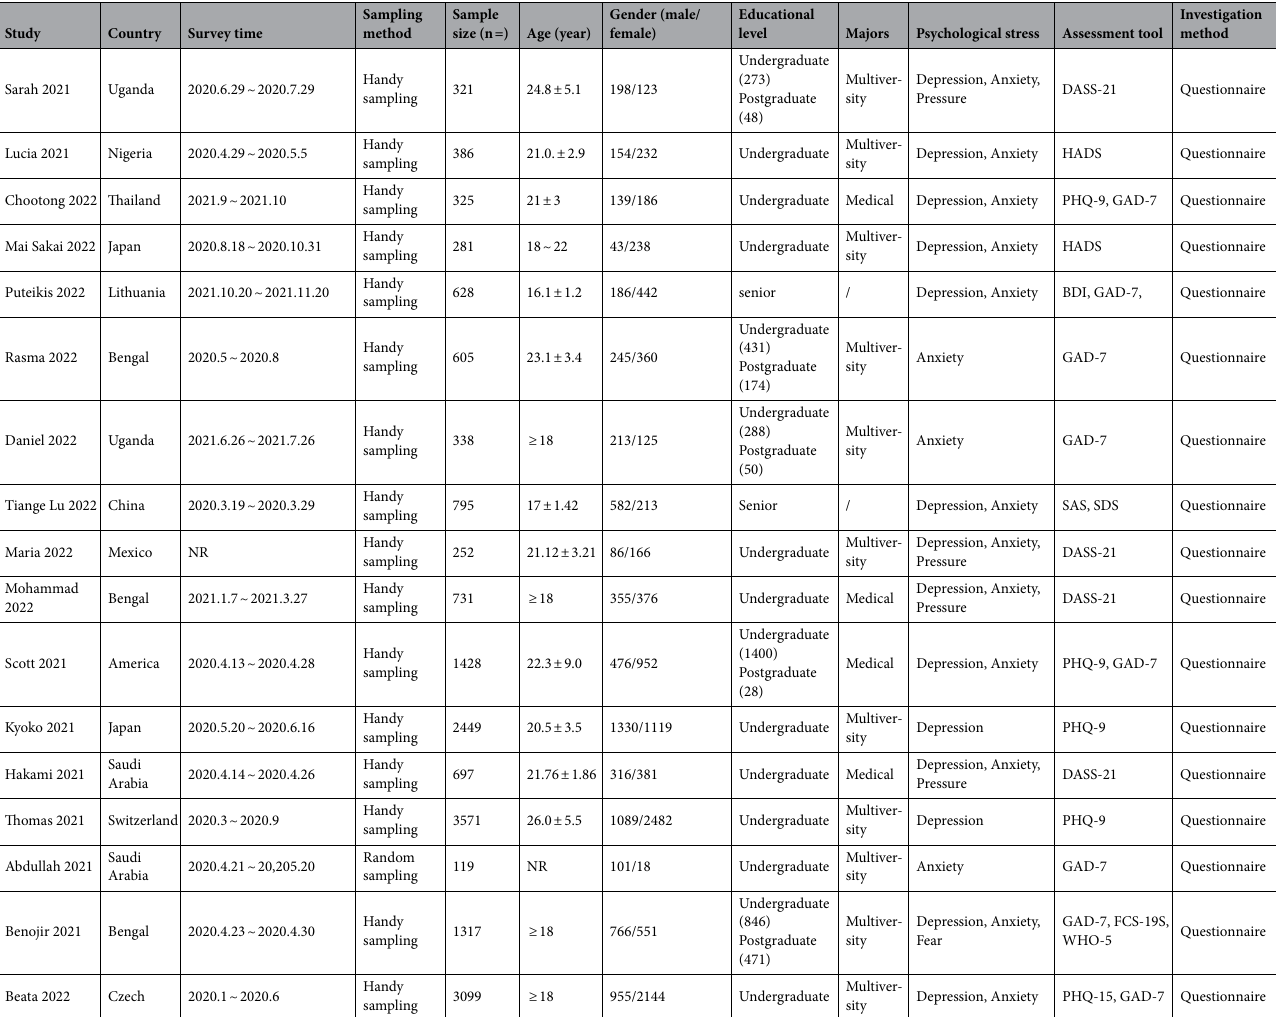
Table 1. The characteristics of 104 studies. SAS Self-rating anxiety scale, PHQ-9 Patient health questionnaire depression module-9, GAD-7 General anxiety disorder-7 item scale, SDS Self-rating depression scale,